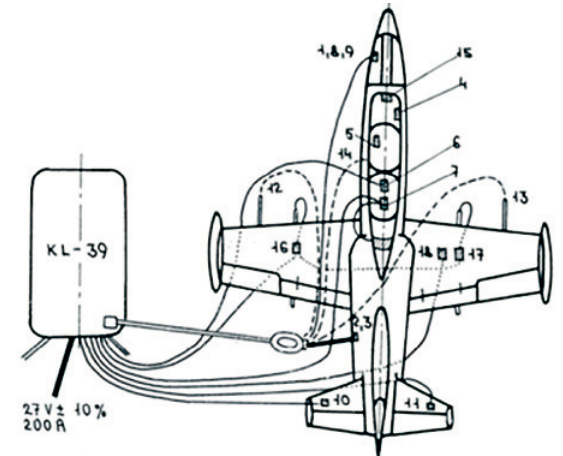
Fig. Scheme of KL-39 connection to an aircraft (Kral et al .